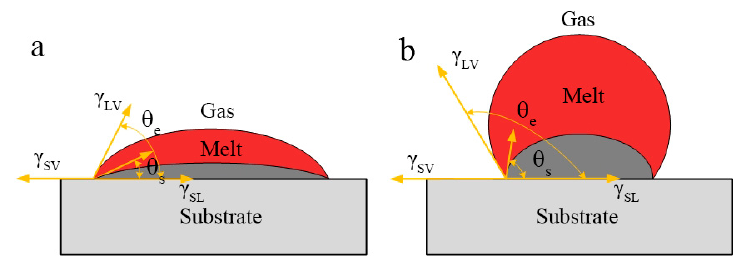
Figure 6. The schematic of liquid metal in the condition of: ( a ) wetting and ( b ) non-wetting.